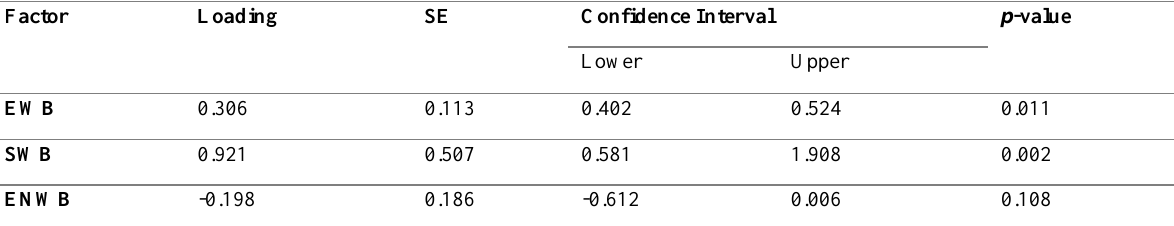
Table 6: Standardized factor loadings for the structural model.